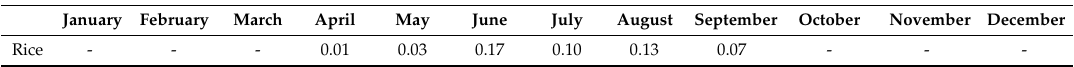
Table 1. The monthly load data for the paddy rice case study in the Geum River Basin (unit: m 3 Geum /fu).